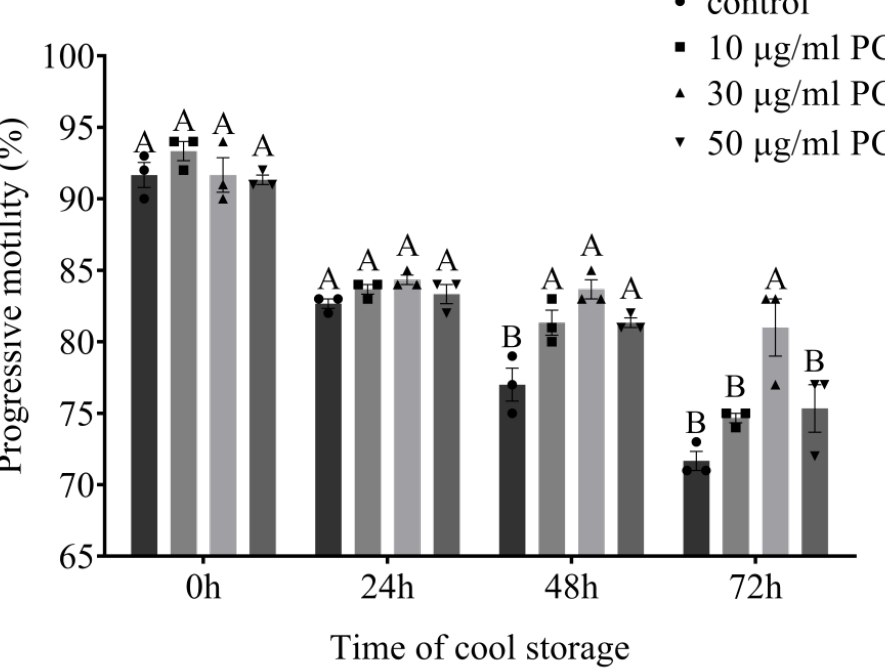
Figure 4. Effects of different concentrations of procyanidin on dog sperm progressive motility after being stored at a cool temperature for 72 h. Values are expressed as mean ± SEM ( n = 3). Different uppercase superscripts (A, B) at the same time indicate significant differences ( p < 0.05). Table 2. Effects of different concentrations of procyanidin on dog sperm motility parameters after being stored at a cool temperature for 72 h.